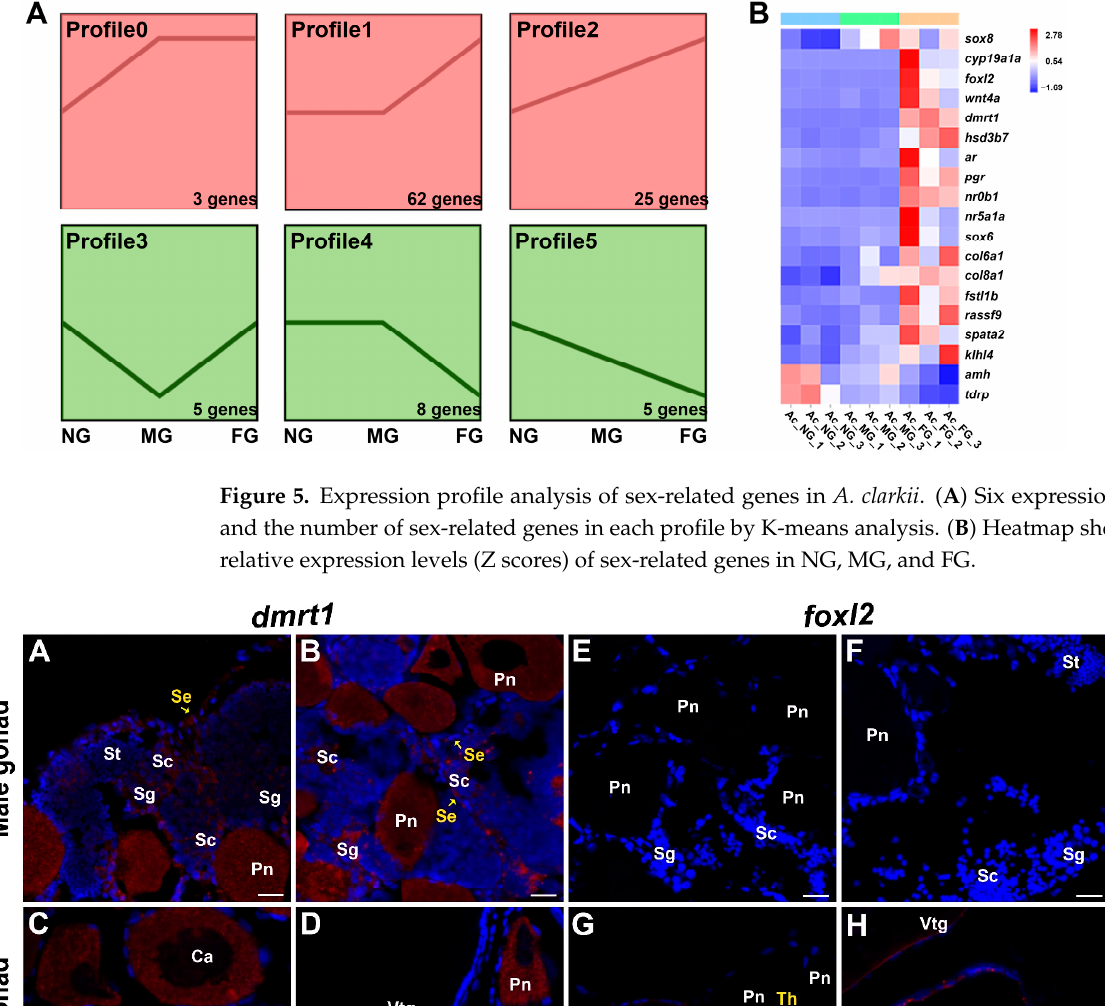
Figure 5. Expression profile analysis of sex-related genes in A. clarkii . ( A ) Six expression profiles and the number of sex-related genes in each profile by K-means analysis. ( B ) Heatmap showing the rel- ative expression levels (Z scores) of sex-related genes in NG, MG, and FG.